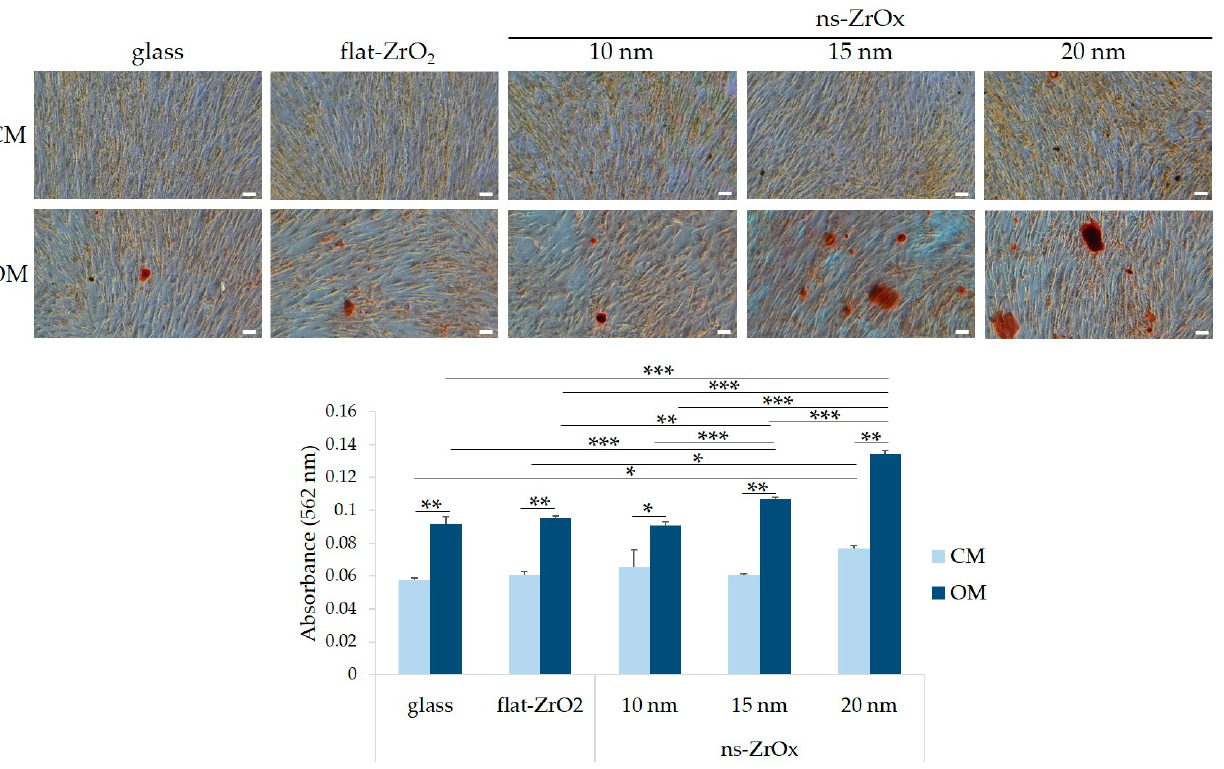
Figure 2. The effects of nanostructured zirconia substrates on the deposition of calcium in the ECM. bMSCs were cultured in CM or OM on ns-ZrOx of different roughness (10, 15, and 20 nm). The flat ‐ ZrO 2 substrate and glass coverslips (glass) were used as controls. After 15 days, Alizarin Red S staining was performed and photographs were taken at 10× magnification ( upper panel ). Scale bar: 150 μ m. After acid extraction, absorbance was measured at 562 nm ( lower panel ). * p ≤ 0.05; ** p ≤ 0.01; *** p ≤ 0.001.